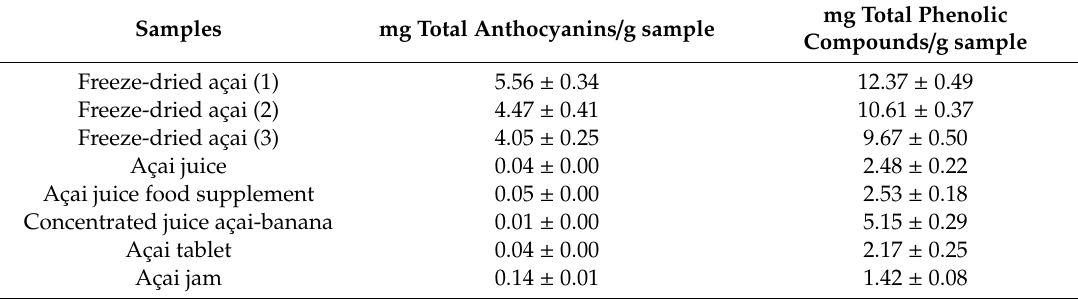
Table 4. The amount of total anthocyanins and total phenolic compounds in real açai samples.